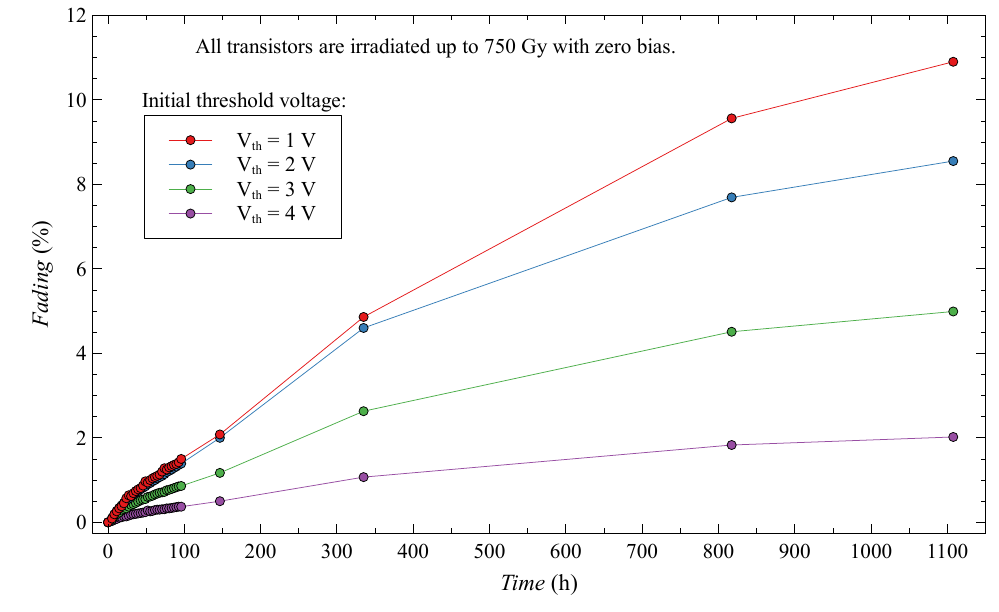
Figure 16. Fading of EPADs with zero bias during irradiation.